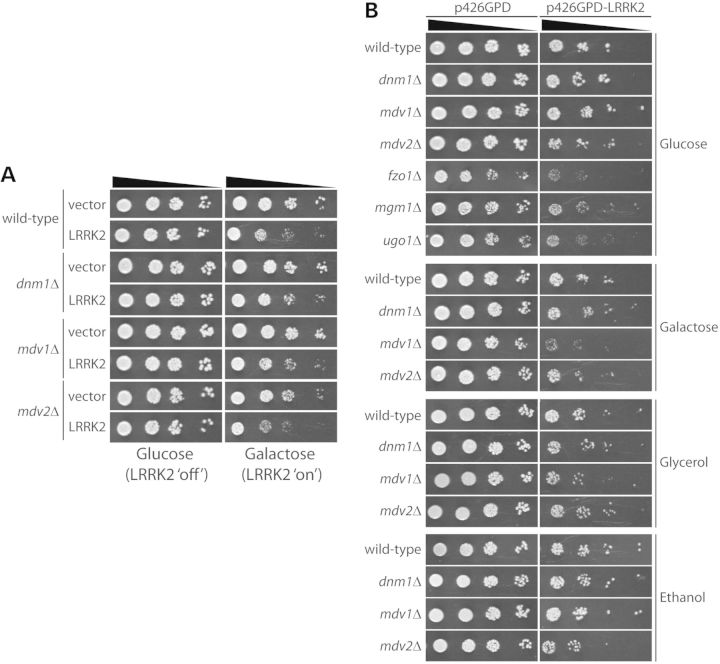
Mitochondrial dynamin GTPases are not required for LRRK2-induced toxicity in yeast. Yeast cells (BY4741 MATa), either WT or deletion mutants, were transformed with (A) galactose-inducible or (B) constitutively expressing (p426GPD) high-copy expression constructs containing human LRRK2 (residues 1300–2527). A corresponding empty vector (p426GAL1 or p426GPD) was used as a control. Cells were spotted onto SC-URA media containing glucose, galactose, glycerol or ethanol as the sole carbon source, as indicated, and incubated at 30°C for up to 6 days. Shown are 5-fold serial dilutions (from left to right) starting with equal numbers of cells. Data are representative of two independently transformed clones for each plasmid.